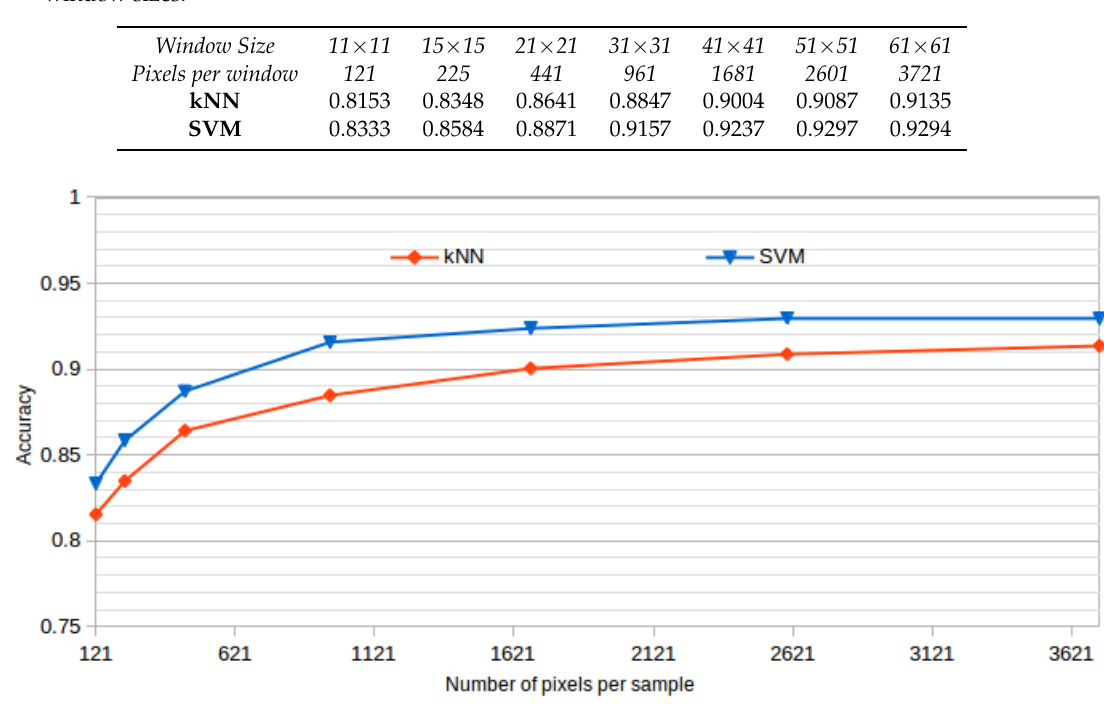
Figure 6. Window size analysis. Best accuracy obtained by each tested classifier and progressive larger window